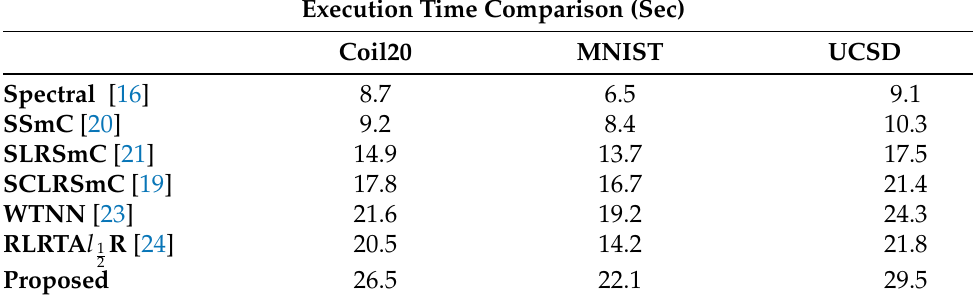
Figure 9. Convergence analysis of the proposed method. ( a ) Convergence analysis of the proposed method with NMI metric using UCSD dataset, ( b ) Convergence analysis of the proposed method with MCR ( m ) metric using Coil20 dataset. Table 3. Execution time comparison of